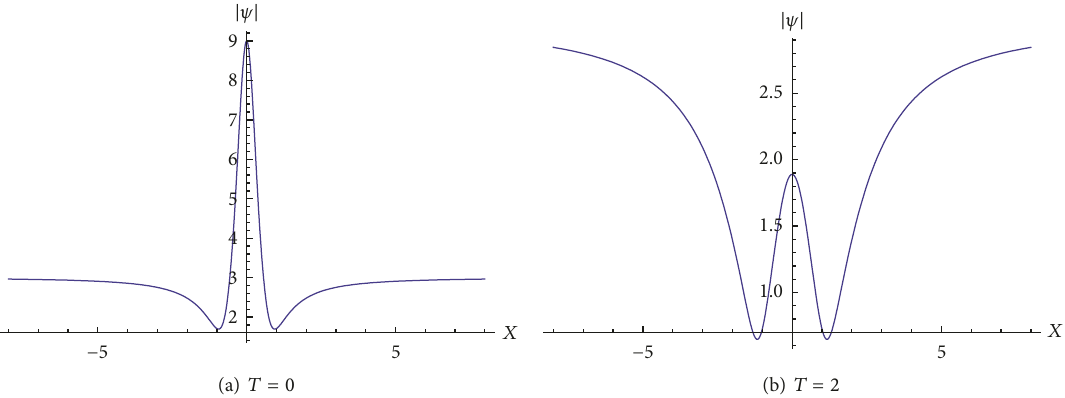
Figure 20: Dynamical evolutions of the rouge wave structure determined by the module of solution